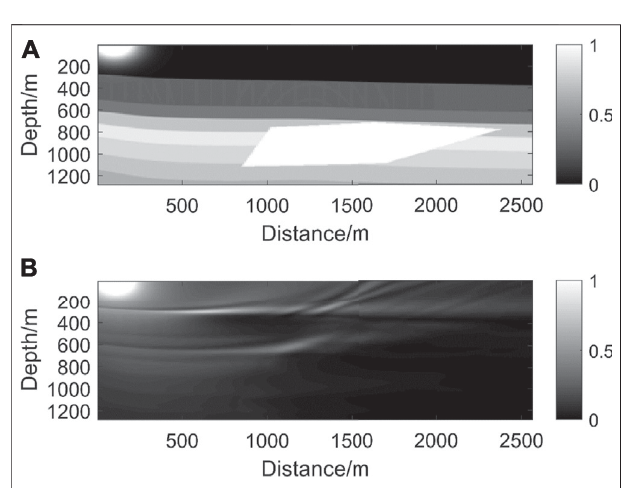
FIGURE 2 | Training dataset. (A) is the velocity model with shot information and (B) is the corresponding illumination result calculated by Eq. 2.2